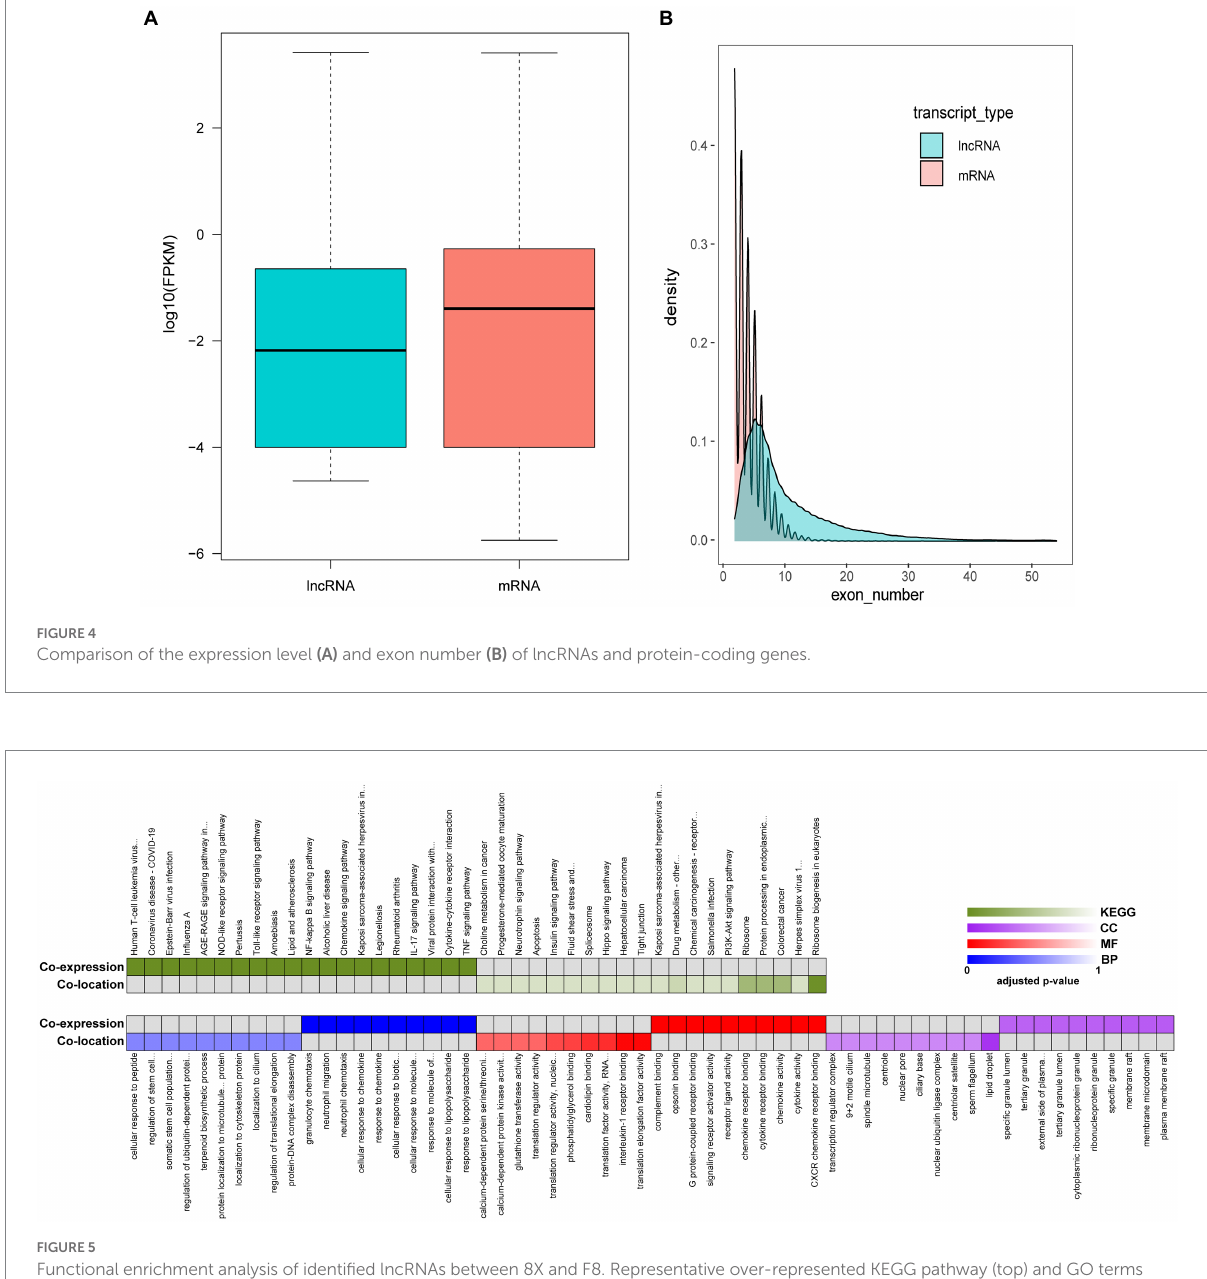
participate in the regulation of the expression of multiple important genes in different processes, including the immune response and protein localization.